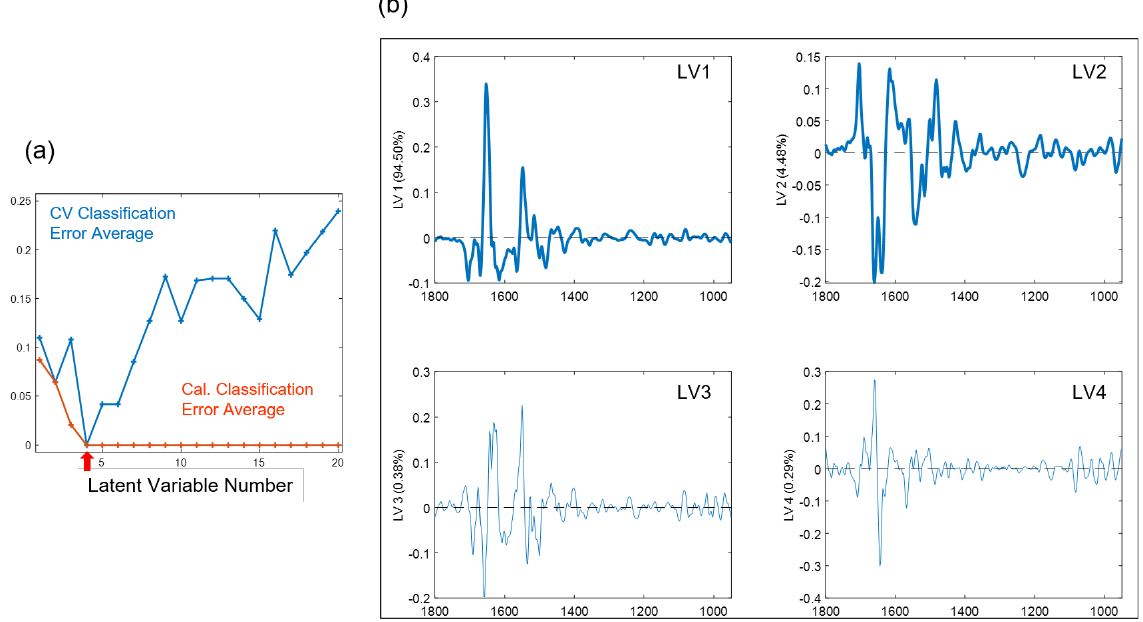
Figure 6. ( a ) Average calibration (Cal.) and cross-validation (CV) modeling errors versus the number of latent variables (LV) and ( b ) four chosen latent variable loadings (LV1 – LV4) for the partial least square discriminant analysis (PLSDA) model. Table 1. Spectral biomarkers identified using feature selection of the PLSDA model for discriminating OSCC from HK samples and their corresponding vibrational modes and biochemical assignments [14,39]. Wavenumber (cm − 1